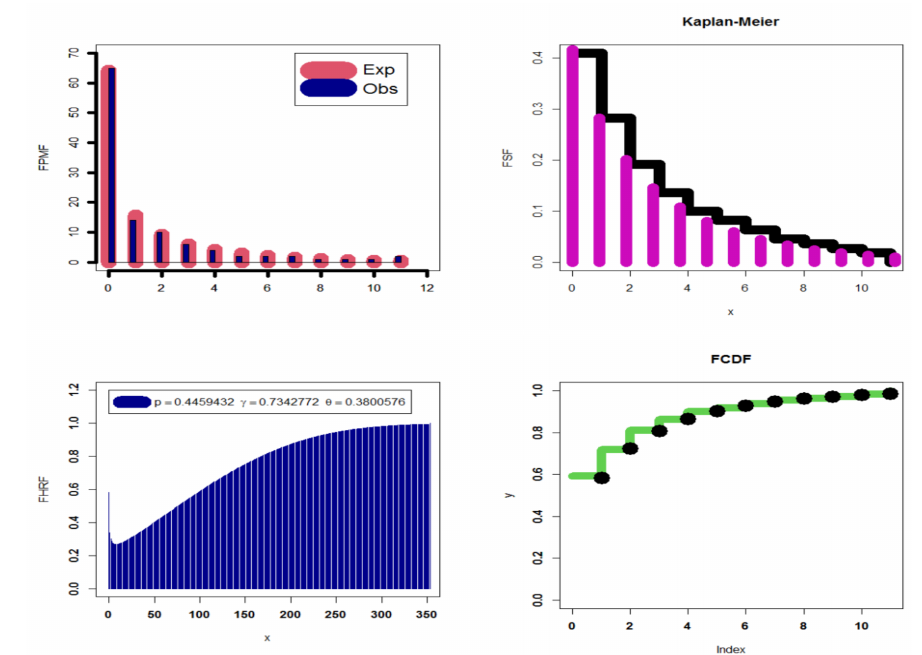
Figure 12. The FPMF, FSF, FHRF, and FCDF plots for dataset